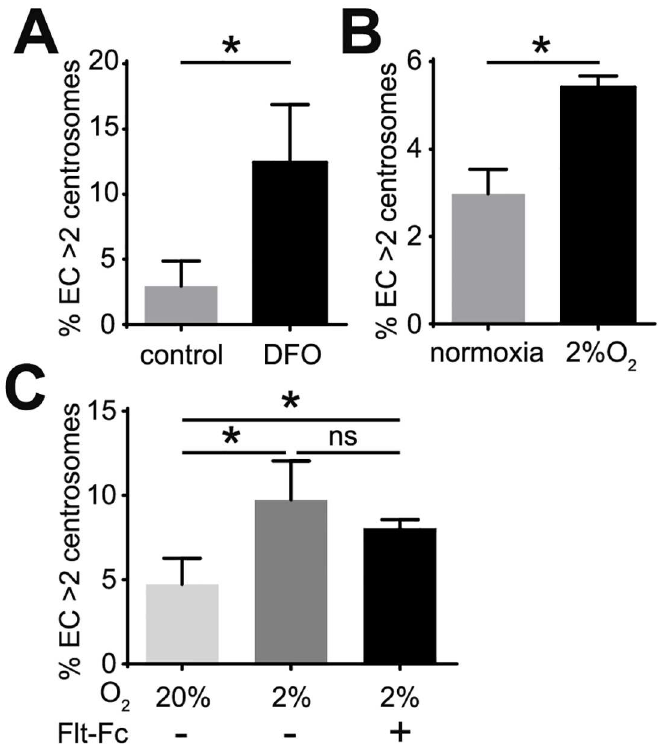
Fig 4. Hypoxia induces excesscentrosomes in EC independent of cell-autonomous VEGF-A signaling. (A) Frequency of excess centrosomesin HUVEC after treatment with 100 μ M hypoxic-mimetic agent desferrioxamine (DFO) for 4 days. (B) Frequency of excess centrosomesin HUVEC after 4 days of incubation in 2% oxygen. (C) Frequency of excess centrosomesin HUVEC after incubation in 20% or 2% oxygen for 4 days and indicatedtreatments. Error bars, standard deviationfrom mean. Statistics: two-tailed unpairedStudent’s t-test. * , p (cid:20) 0.05; ns, not